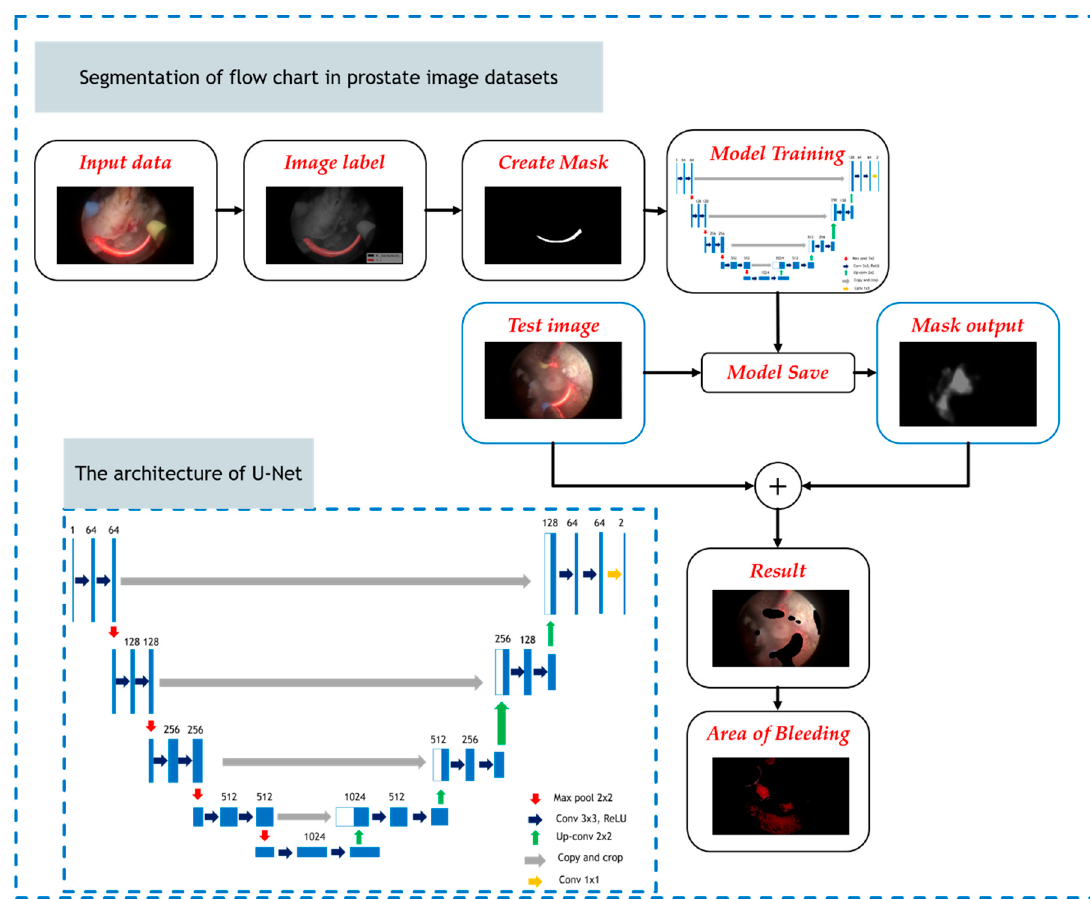
Figure 5. The flowchart of the U-Net deep learning model.